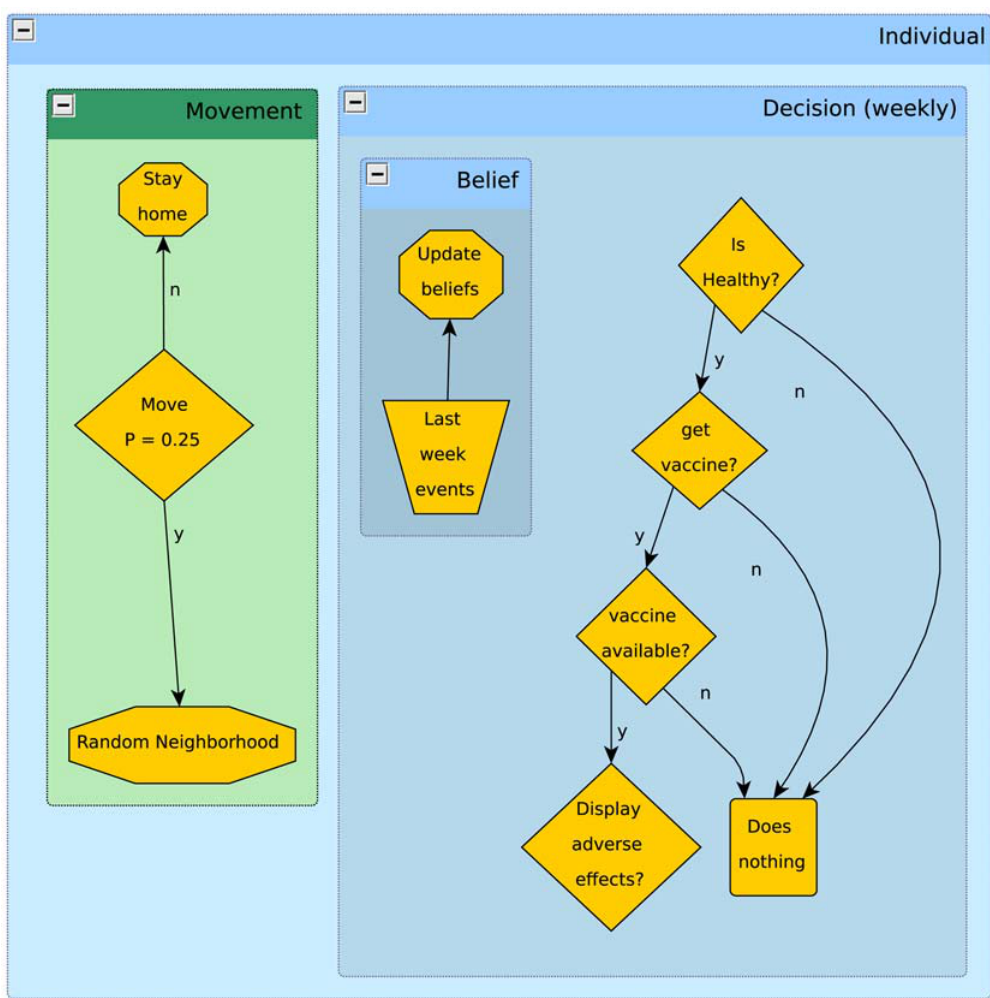
Figure 8. Daily and weekly events that determine individual activity. Movement decisions take place on a daily basis.